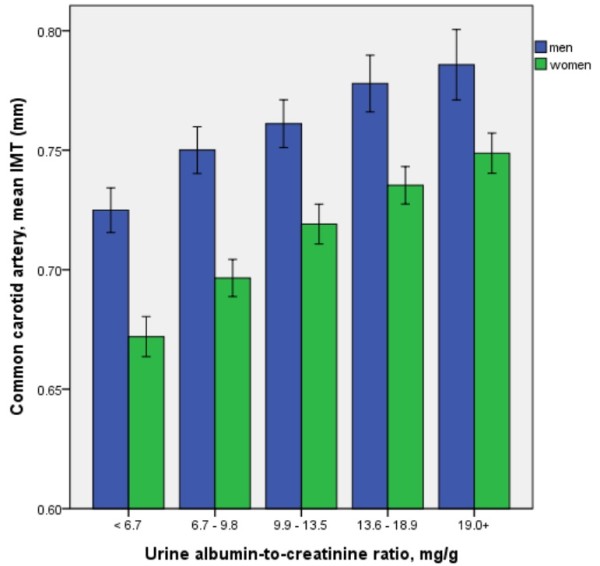
The mean values of common carotid intima-media thickness (CIMT) according to quintiles of normal UACR values in men and women (both p values < 0.001 by analysis of variance, respectively). Error bars indicate 95% confidence intervals.